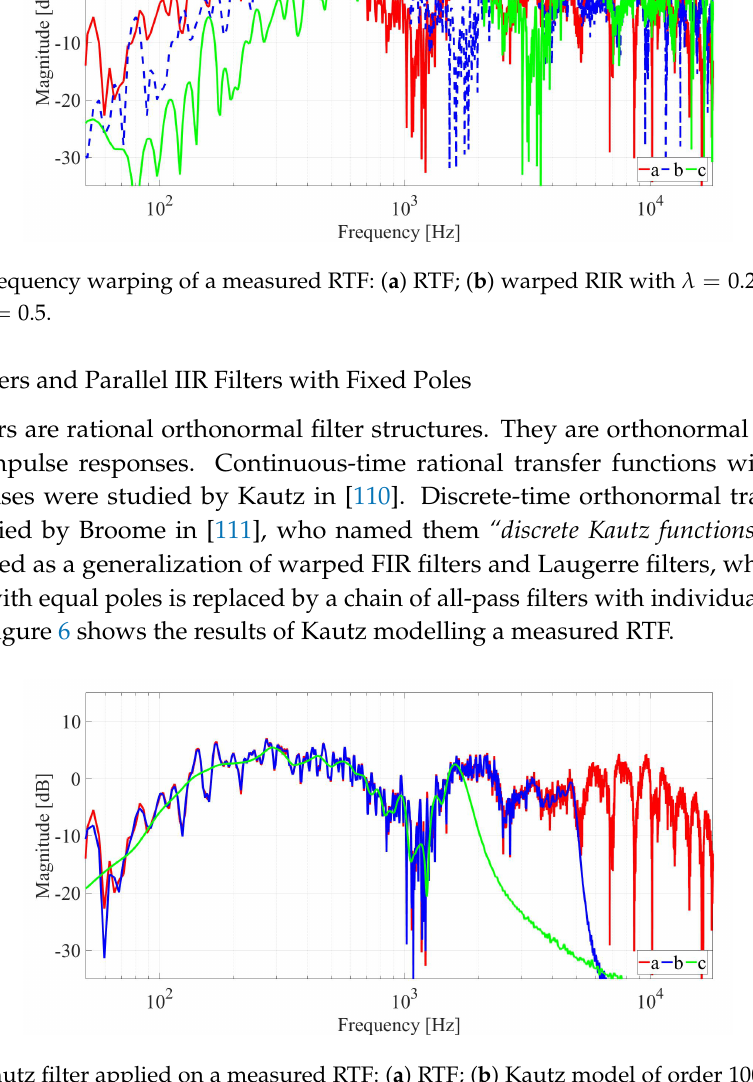
Figure 6. Kautz filter applied on a measured RTF: ( a ) RTF; ( b ) Kautz model of order 1000; ( c ) Kautz model of order